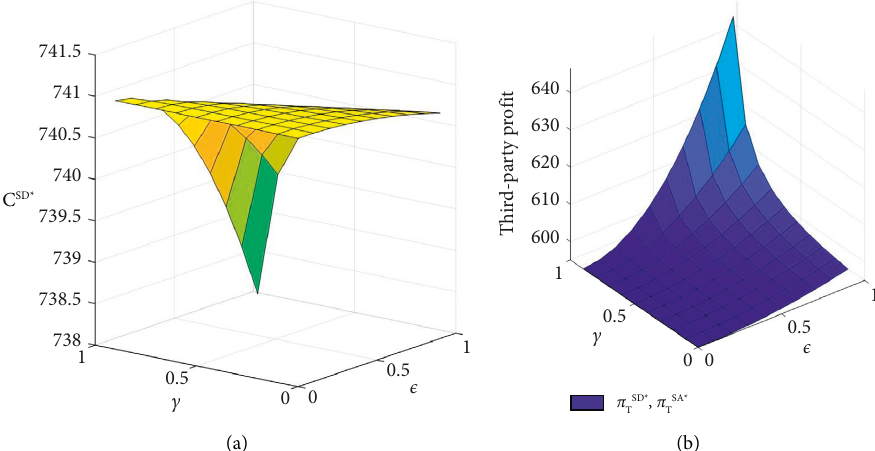
Figure 7: The effect of c and ϵ on carbon emissions and third-party profit (a) the effect on carbon emissions (SD as an example) (b) the effect on the third-party profit.